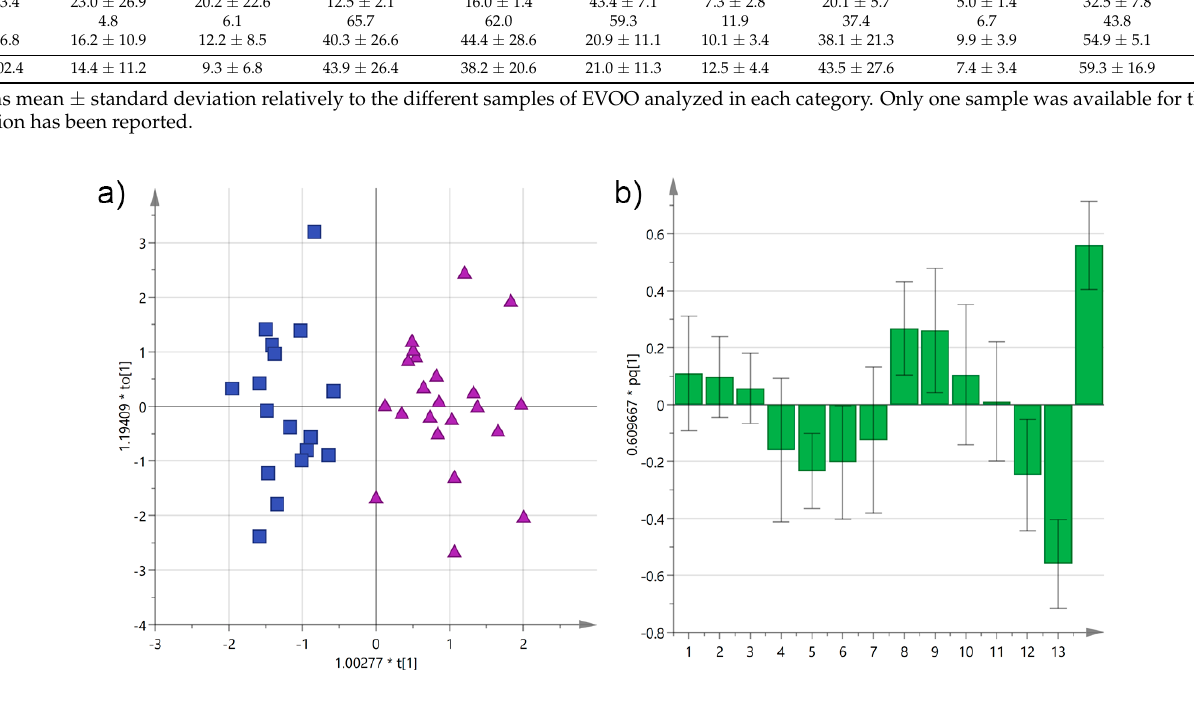
Figure 5. ( a ) Orthogonal partial least-squares discriminant analysis (OPLS-DA) score plot for EVOO samples from Salento categorized by cultivar (blue squares = Cellina; purple triangles = Ogliarola); ( b ) OPLS-DA loadings column plot for the first predictive component of the model (variables: 1 = total biophenols; 2